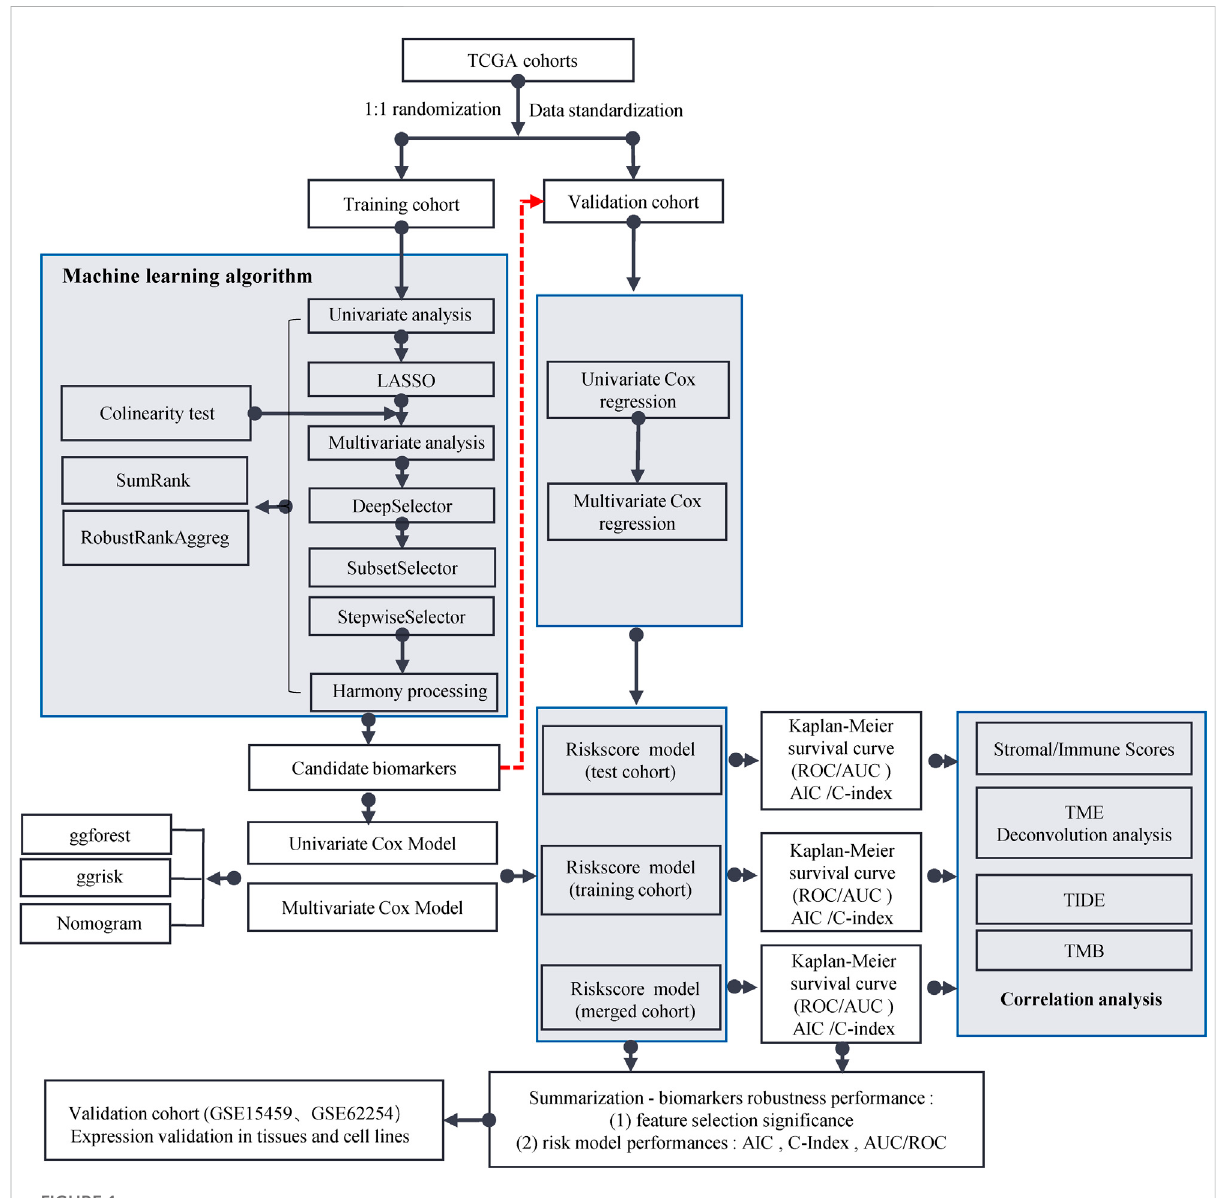
FIGURE 1 Flow chart of this